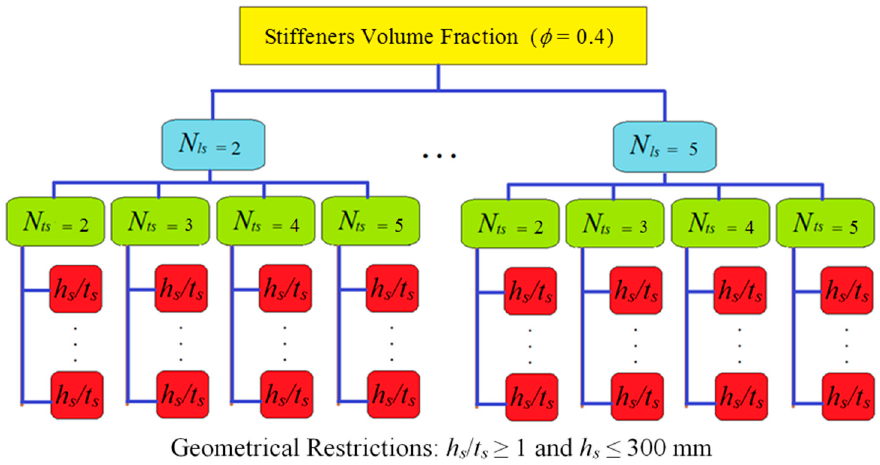
Figure 6. Application of the constructal design method in the definition of the search space.